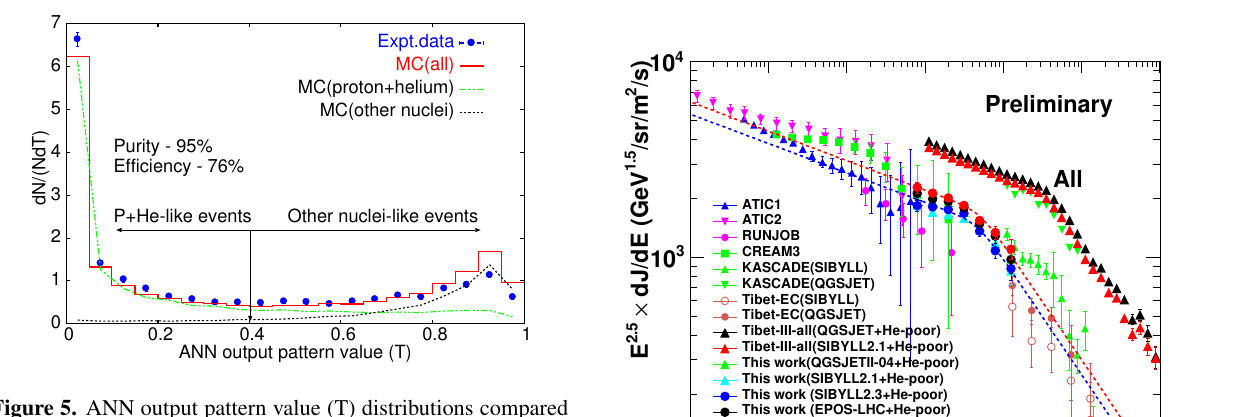
N b , Figure 4. The comparison of some observable parameters ( Figure 3. E ffi ciency S Ω of YAC-I array for Proton + Helium un- N btop , R N b R , ) between experimental data and MC simula- (cid:31) (cid:30) (cid:31) (cid:30) der the models mentioned above. (cid:31) tion which are calculated for various combination of interaction and composition models. Table 1. Statistics of air-shower core events in MC simulation and experiment. Table 2. The average purity and e ffi ciency of the selected events by T c 0.4 ≤